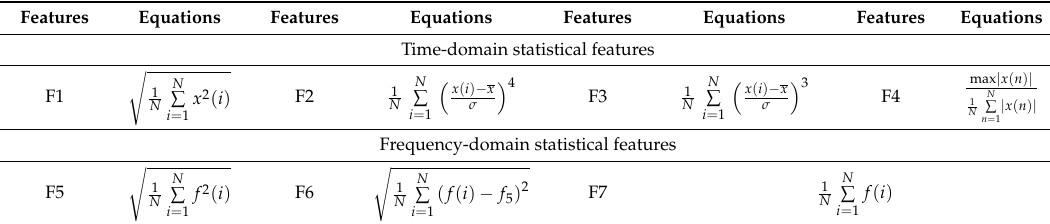
Table 2. Definition of the time-domain and frequency-domain statistical parameters (i.e., features) of this study.